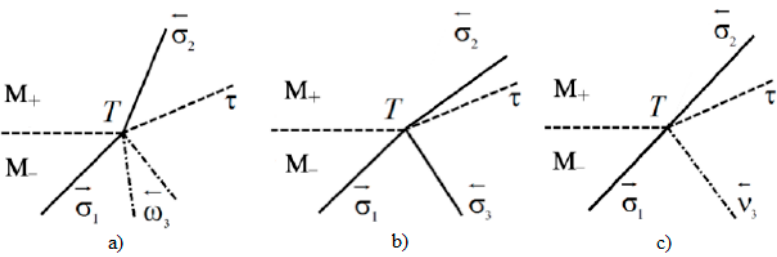
Figure 3. Regular refraction of oblique shock wave σ 1 on tangential discontinuity τ : ( a ) refraction with reflected rarefaction wave, ( b ) refraction with reflected shock wave, ( c ) characteristic refraction, where the reflected discontinuity is the discontinuous characteristic.